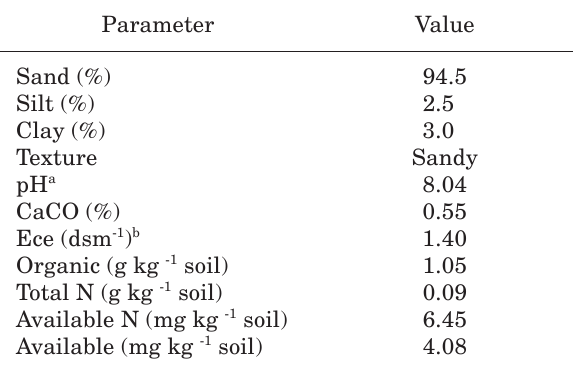
Table 1. Physical and chemical properties of the soil used in the